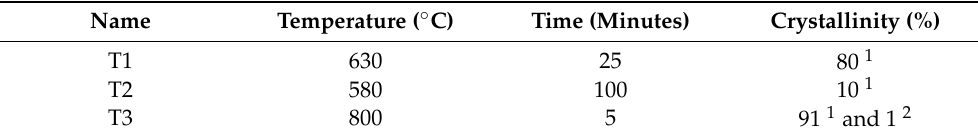
Table 1. Thermal treatments used in this work, with the resulting crystallinity index. Name Temperature ( ◦ C) Time (Minutes) Crystallinity (%)